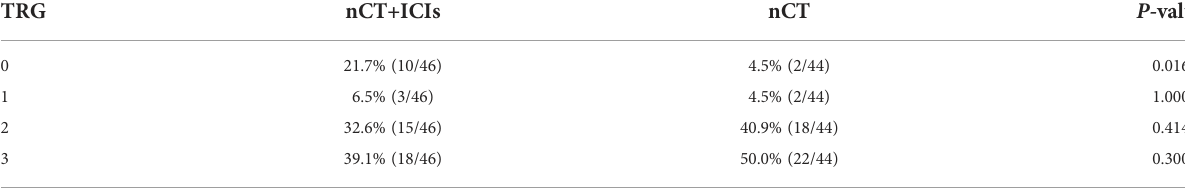
TABLE 2 Comparison of TRG between the two groups.